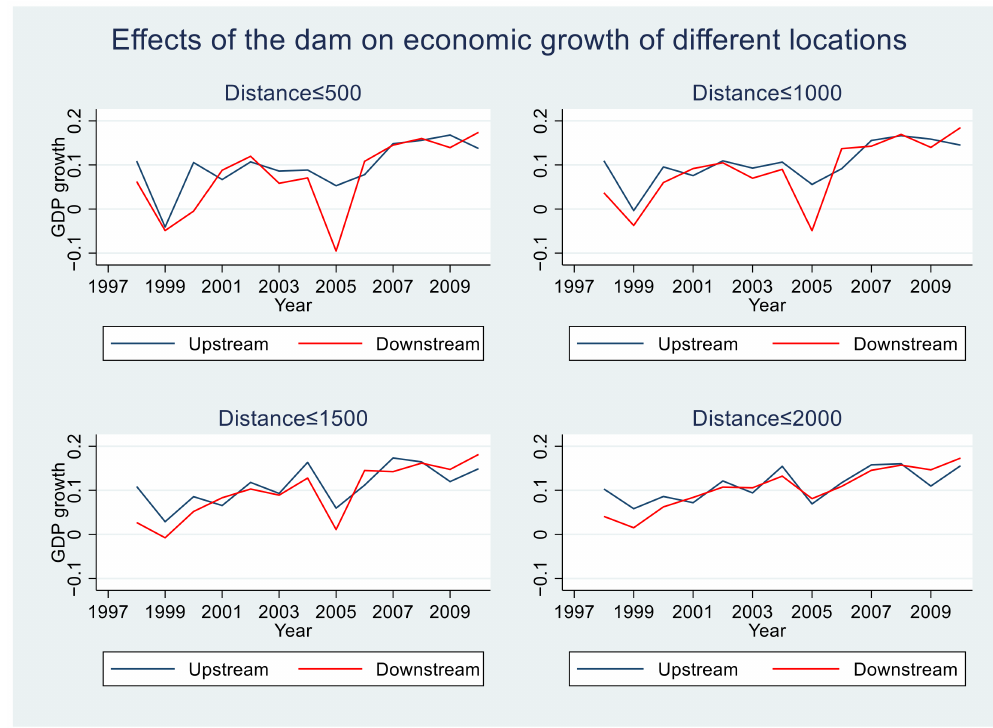
Figure 2. Effects of the damming on the GDP growth of cotton production for upstream and downstream counties. Note: the unit of the distance in each graph is km.